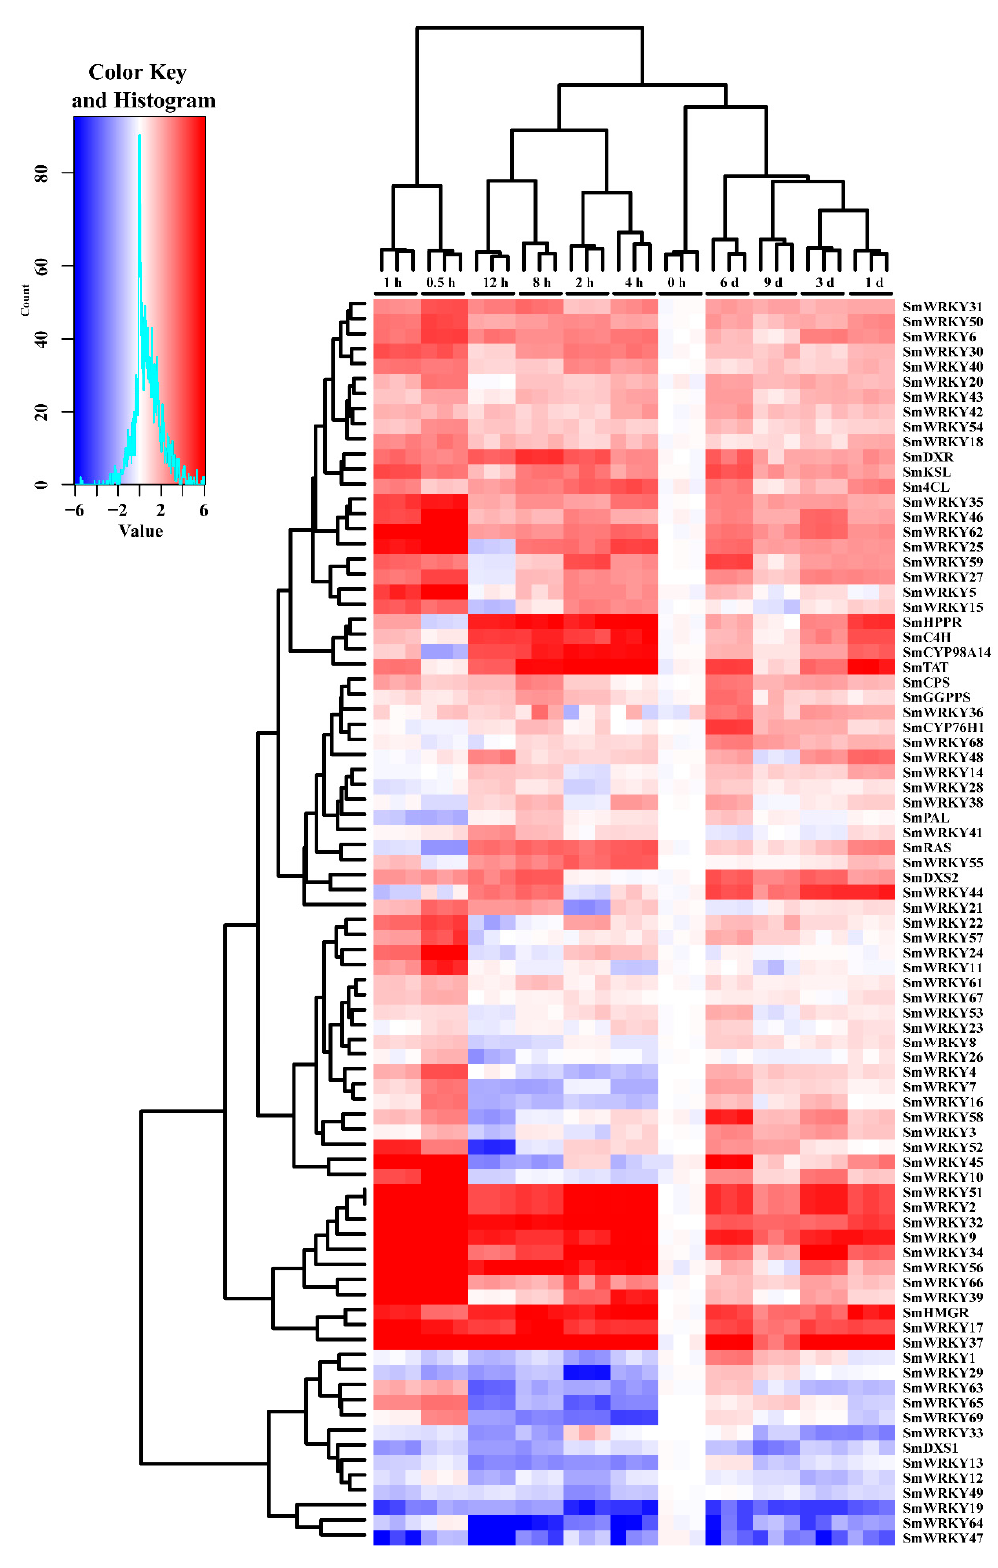
Figure 3. Expression of SmWRKY genes and biosynthetic genes in different tissues and flowering phase. Hierarchical clustering and expression profiles of the SmWRKYs and biosynthetic genes in different organs/tissues in S. miltiorrhiza . Blocks with colors indicate low/down expression (blue), high/up expression (red), or no expression/no change (white).